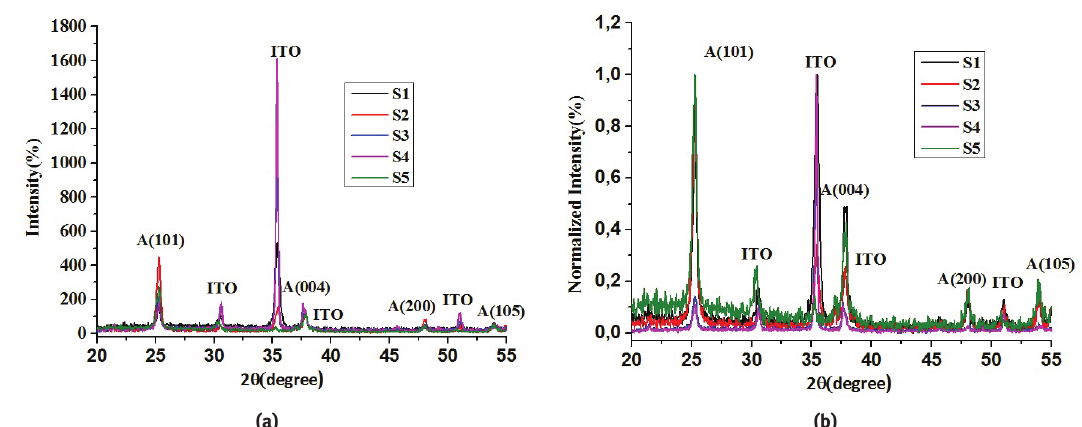
Figure 4: (a) XRD graphs (b) Normalized XRD graphs for patterns of bilayer TiO